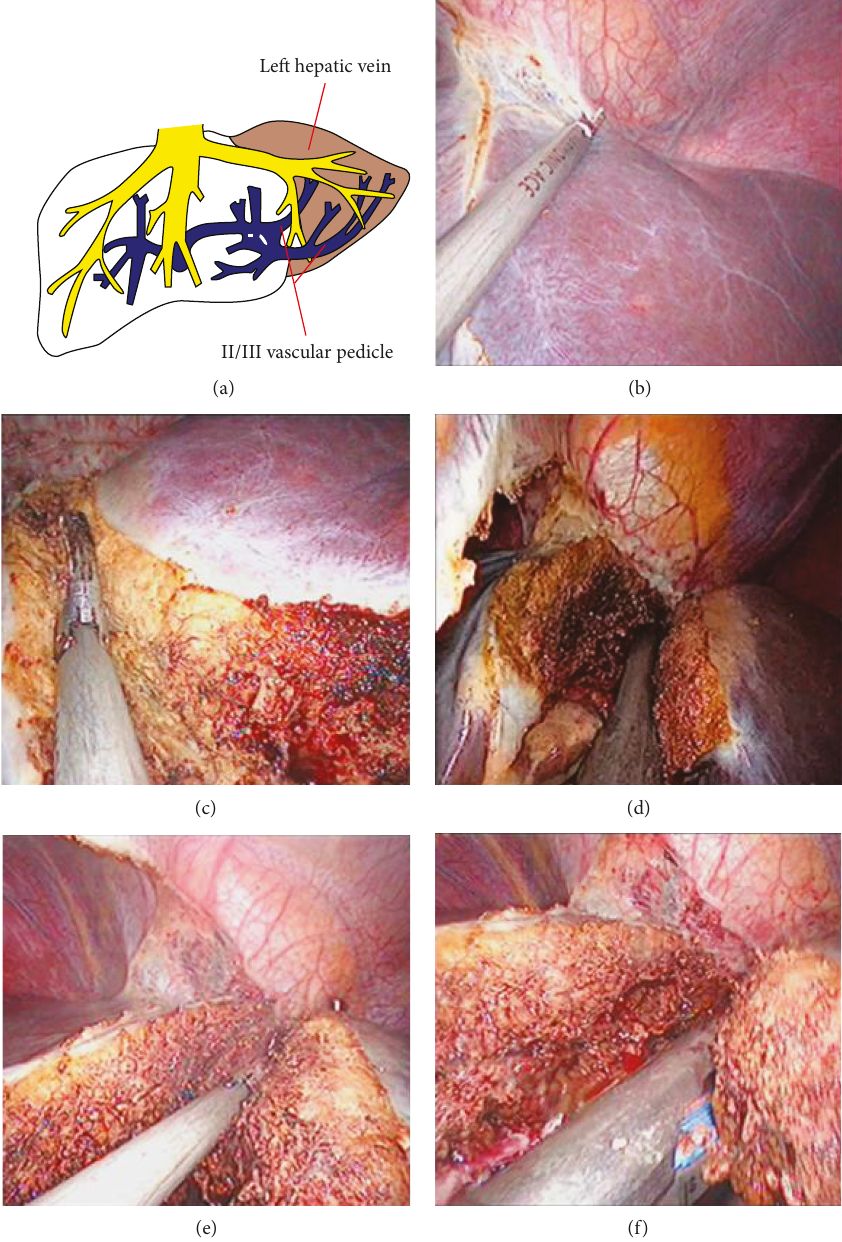
Figure 1: (a) The “ fi ve-step ” single-port laparoscopic hepatic left lateral sectionectomy is developed based on the anatomical features of the hepatic left lateral lobe. (b) The left hepatic lateral lobe was fully freed. (c) The ultrasonic scalpel was used to expose the vascular pedicle of segments II and III. (d) Articulating linear cutter stapler was used to divide the II/III vascular pedicle. (e) The ultrasonic scalpel was used to expose the left hepatic vein. (f) Linear cutter stapler was used to divide the left hepatic